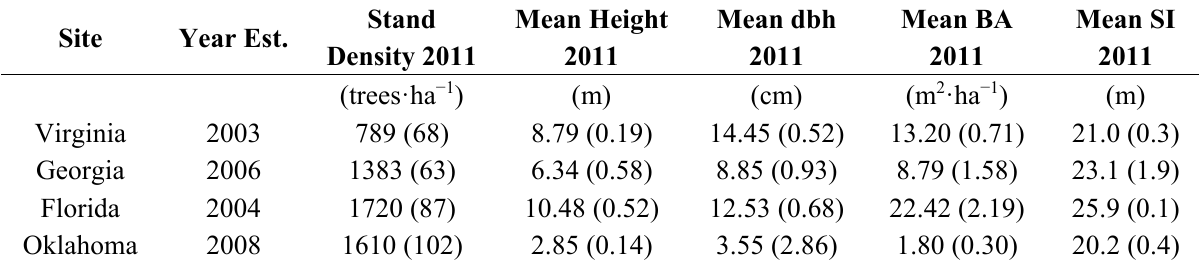
Table 4. Plot-level average stand density, tree height, tree diameter breast height (dbh), stand basal area (BA) and site index (SI) (base age 25) at time of treatment initiation ( n = 16). Numbers in parentheses are the standard